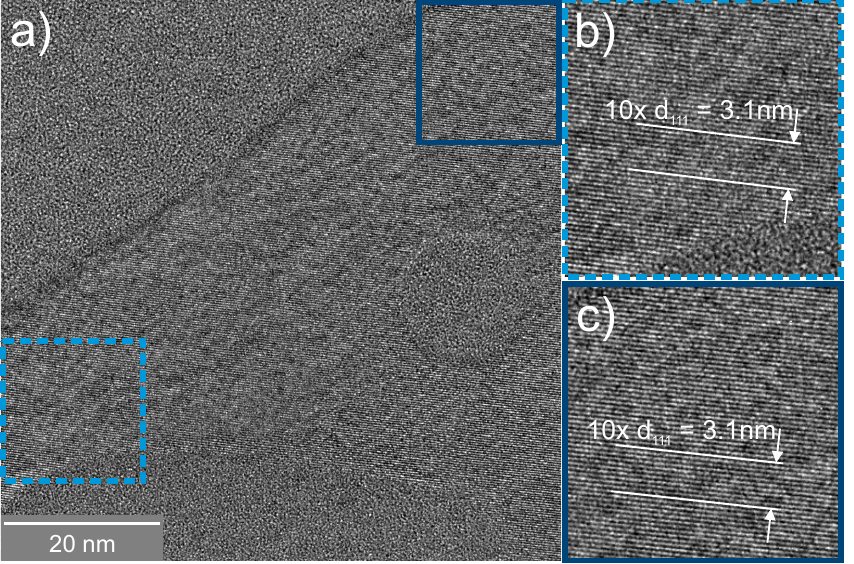
Figure 5. High-resolution TEM image of laser-crystallized SiO 0.6 layers. ( a ) Si (111) lattice fringes expand across the whole field of view. The matrix surrounding the crystal is assumed to be SiO 2 . ( b , c ) show enlargements of diagonal opposite areas of ( a